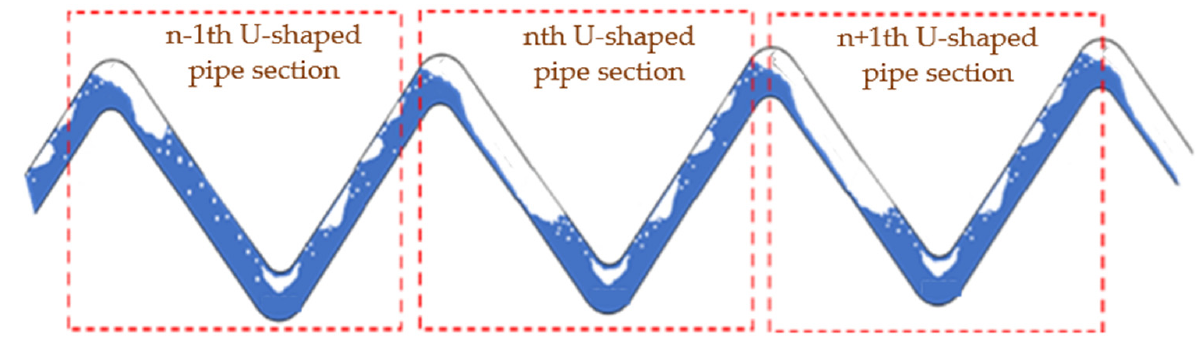
Figure 7. Schematic diagram of continuous U-shaped gas accumulation.